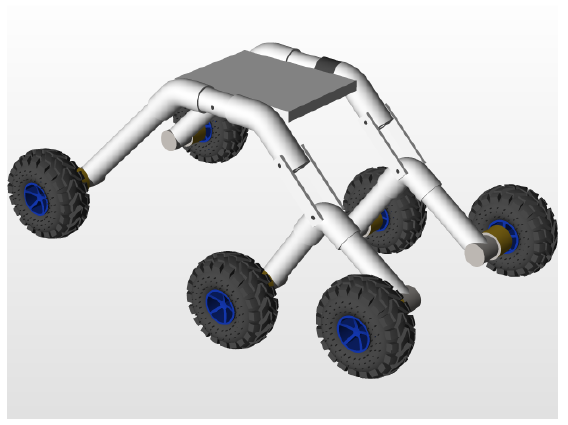
Figure 6. SLAM Figure 2. Basic ROS Program.